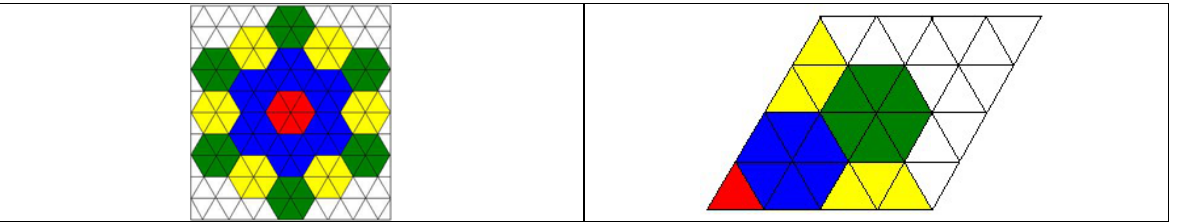
Figure 1. Rectangular Triangular-Z Mesh Examples